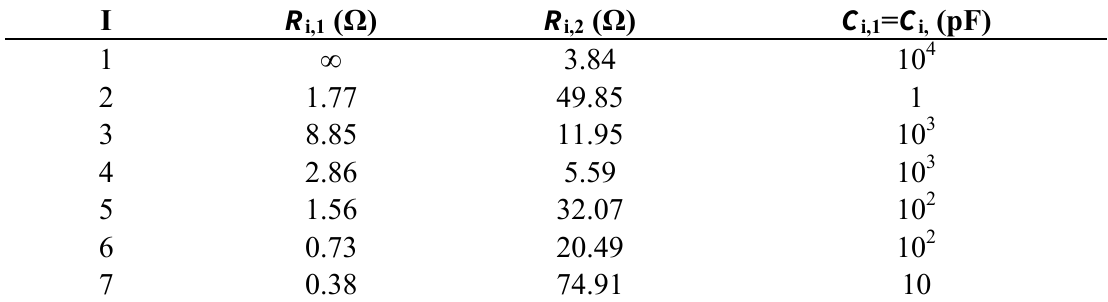
Table 3. Component values (corresponding to factors 1–7).